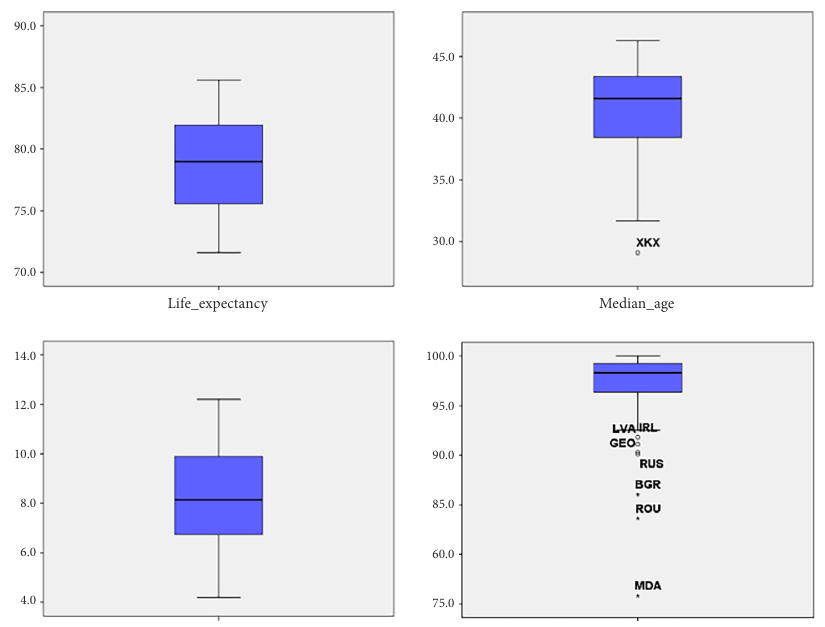
Figure 3. Box-plots for population health-related indicators (source: authors’ computation using IBM SPSS Statistics